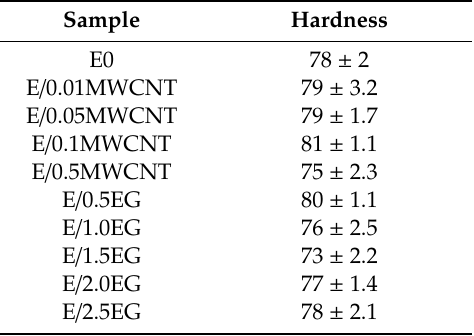
Table 3. Shore D hardness results of epoxy / MWCNTs and epoxy / EG composites.